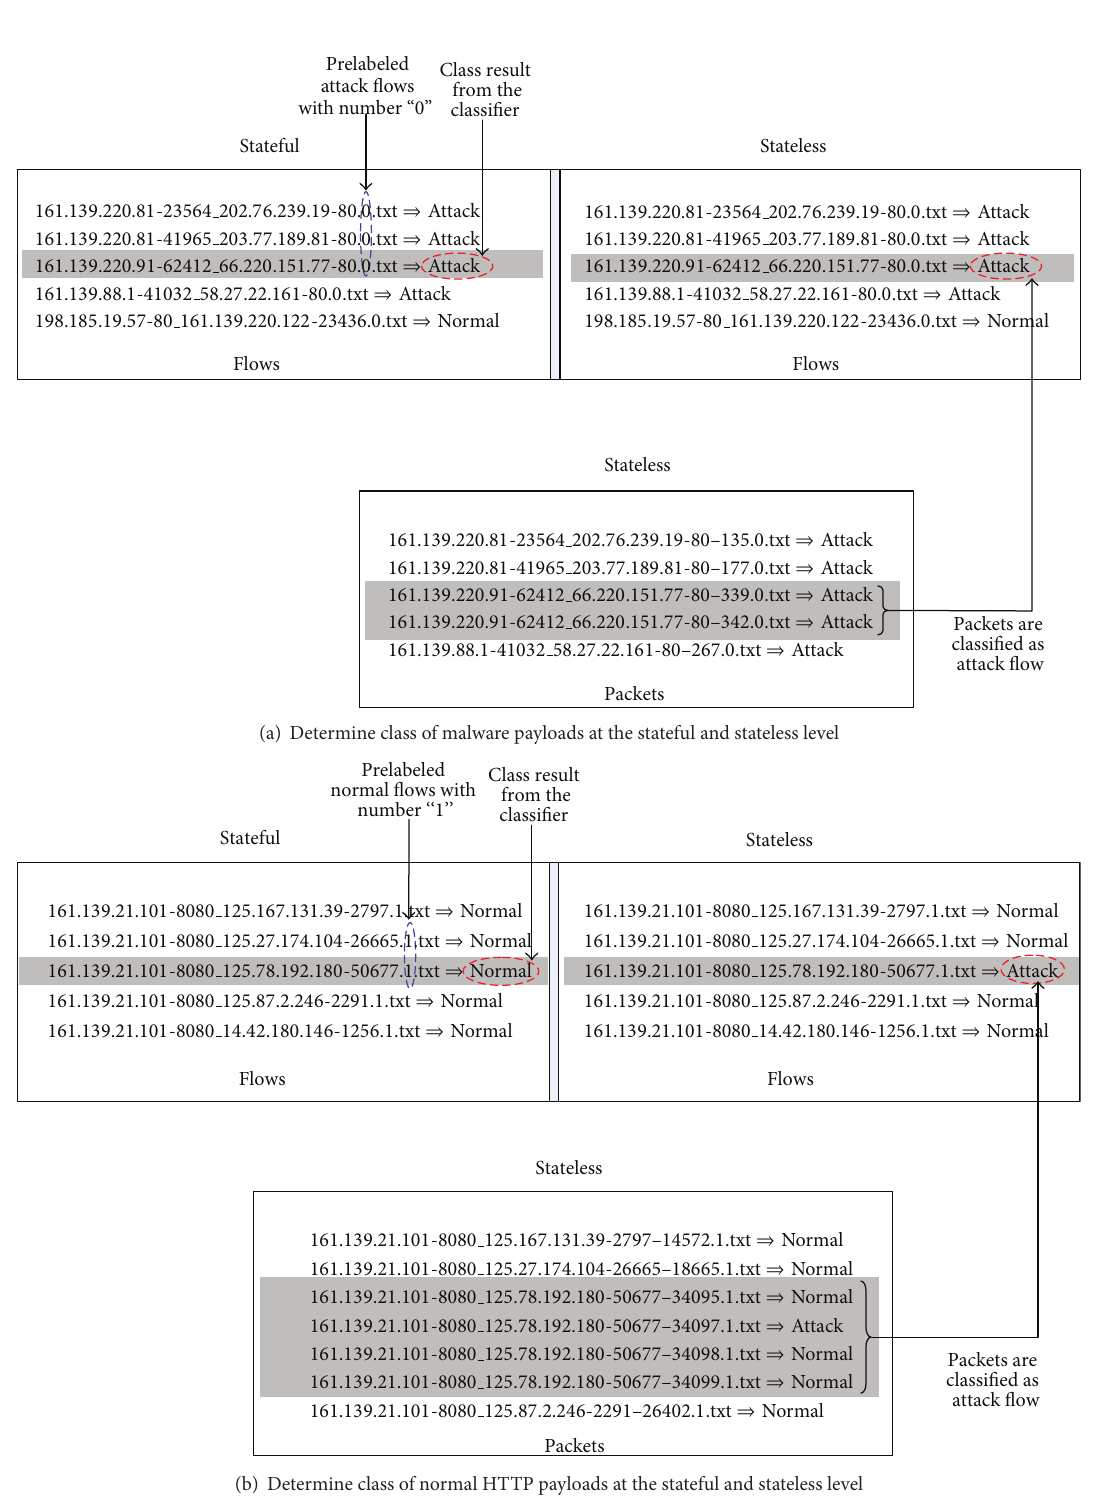
Figure 7: Determination of class for payload at stateful and stateless